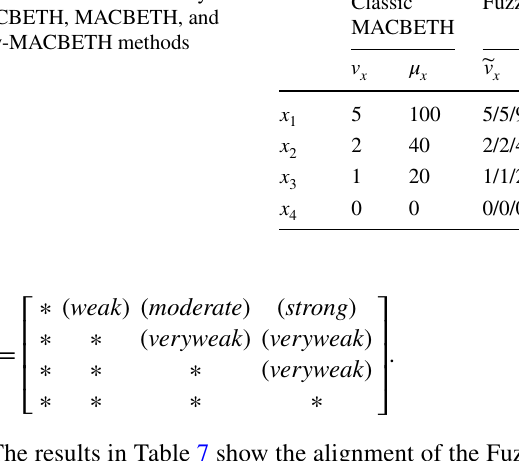
Table 8 Results of the Fuzzy- MACBETH, MACBETH, and Grey-MACBETH methods